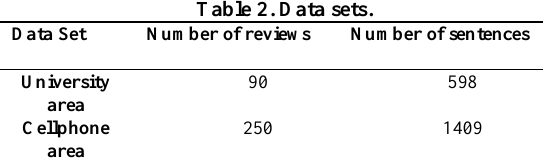
Table 2. Data sets.